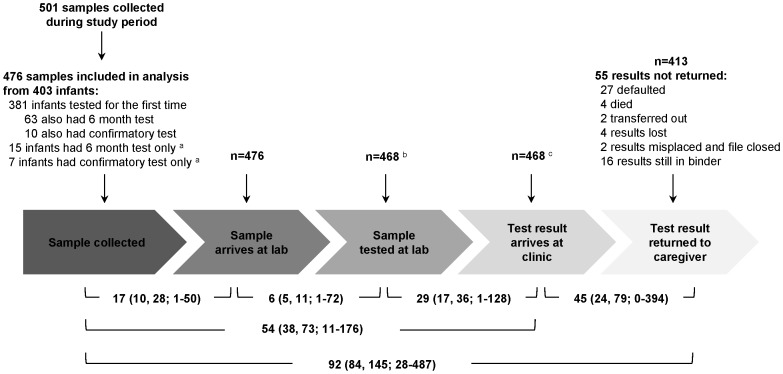
Median turnaround time (IQR; range) in days for early infant diagnosis in rural Zambia, 2010–2012.
aThese infants were first tested before the study began; bEight samples were lost at the laboratory; cSix results were missing date of return.